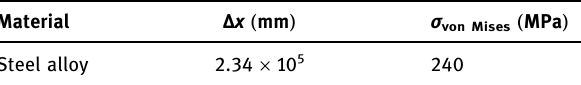
Table 1: Properties of the material steel alloy on the